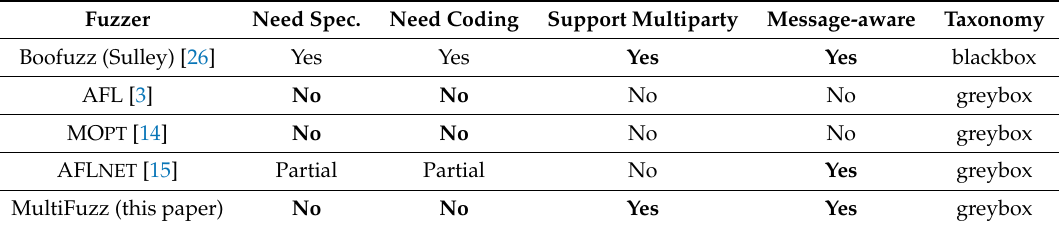
Table 1. Fuzzer comparisons. “Partial” means some knowledge or work is needed. Fuzzer Need Spec. Need Coding Support Multiparty Message-aware Taxonomy Boofuzz (Sulley)